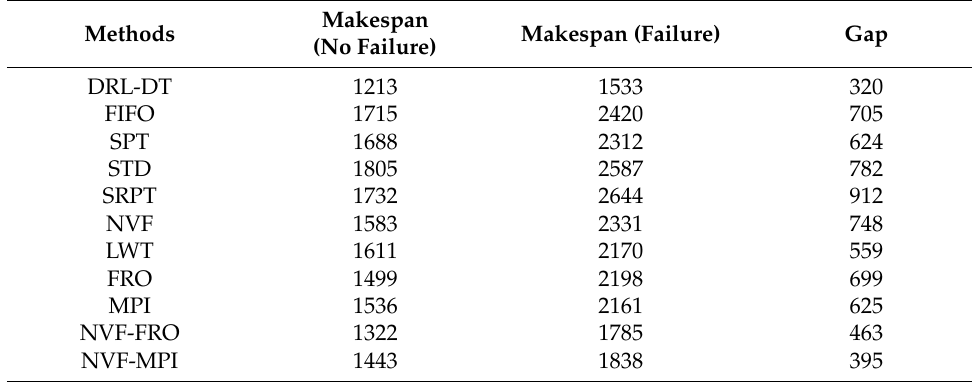
Figure 7. Scheduling Gantt chart (DRL-DT). Table 3. Makespan (s) comparison of each